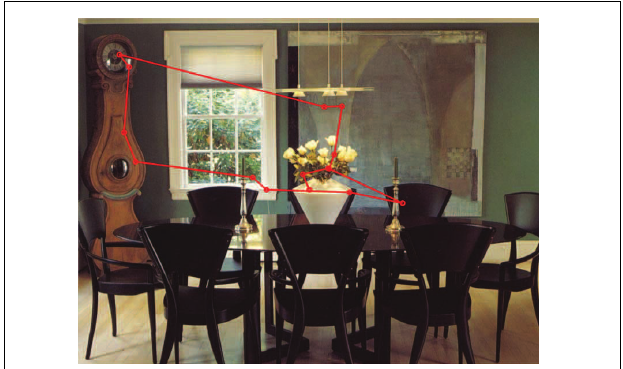
FIGURE 6 | Example illustrating the negative interaction of Attention and Position. The objects named by the participant whose scan pattern is shown were: flowers, candle, table, chair, and